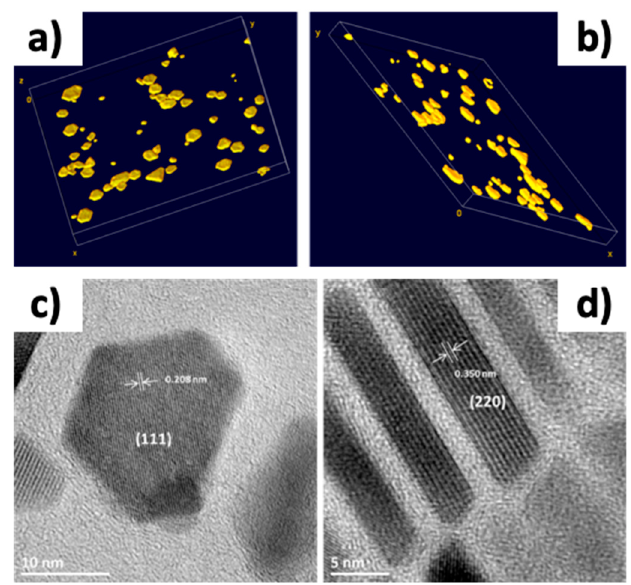
Figure 5. 3D TEM reconstruction of the nanoplates ( a , b ) and high resolution transmission electron microscopy (HR-TEM) images of the long face of a platelets ( c ); and of the side ( d ).